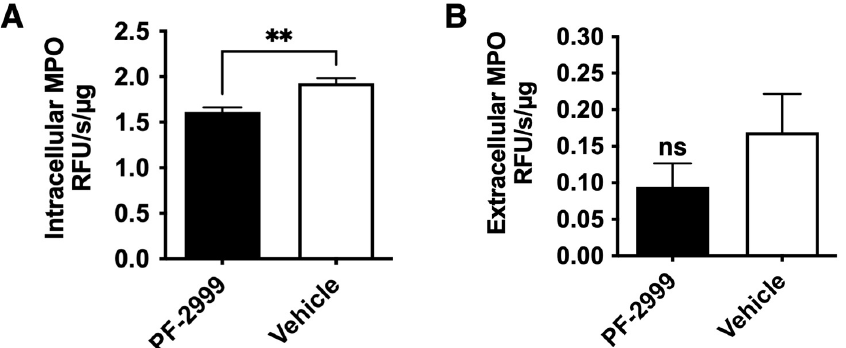
Figure 3. MPO activity assay with mice treated with 15 mg/kg of PF-2999. ( A ) Intracellular MPO activity in mice treated with PF-2999 was signi fi cantly lower compared to that in the control group (** p < 0.01, n = 4 for each group, one-tailed t -test). ( B ) Extracellular MPO activity in mice treated with PF-2999 showed 38% reduction compared to that in the control group (ns = not signi fi cant, p = 0.17, n = 4 for each group, one-tailed t -test). n = 4 for each group, one-tailed t